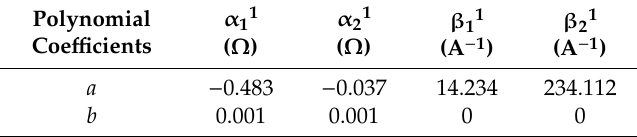
Table 14. Nonlinear parameters for MT5 pi-circuit as a function of soil resistivity.